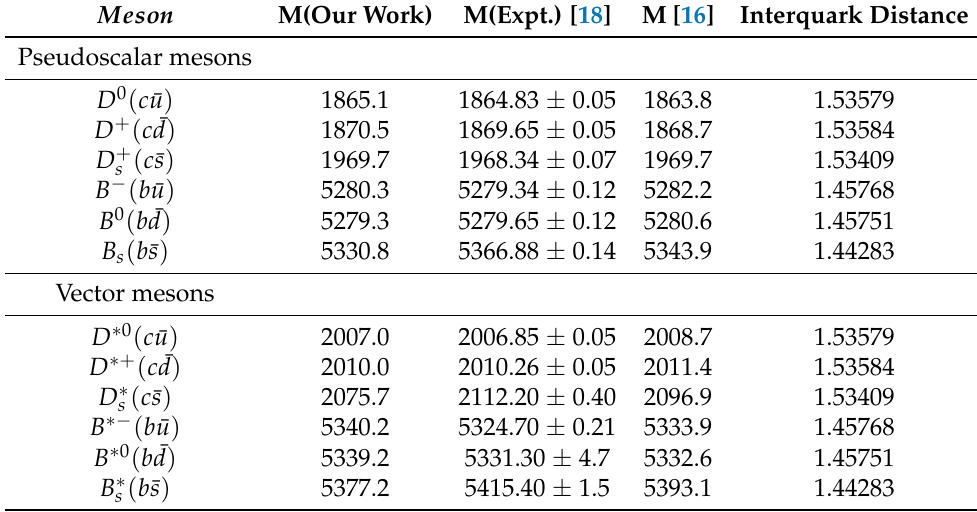
Table 1. The computed masses of the heavy-light pseudoscalar and vector mesons in MeV, with their interquark-distances in units of GeV − 1 . Meson M(Our Work) M(Expt.) [18] M [16] Interquark Distance Pseudoscalar